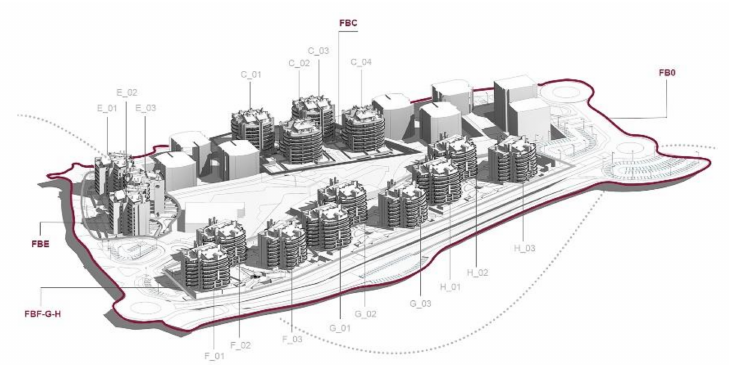
Figure 1. Rione Rinascimento III three-dimensional BIM model overview, consisting of encoded functional blocks (FB) and building models (from C_0n to